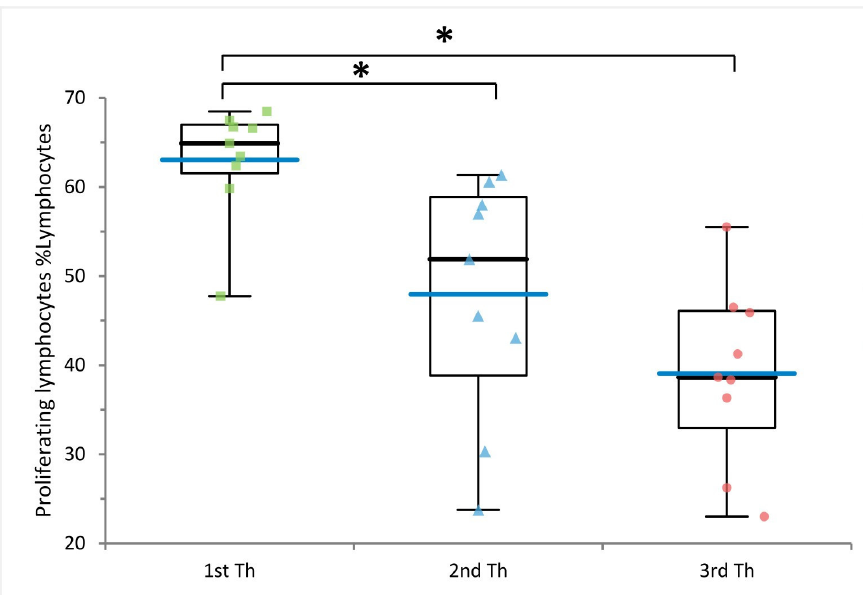
Figure 5. Effect of multiple freezing cycles on lymphocyte proliferation. Comparison of lymphocyte proliferation rate measured on nine PBMC samples after the first, second and third thawing (Th). * p -values from the paired t -test <0.05. Blue bars indicate mean values.